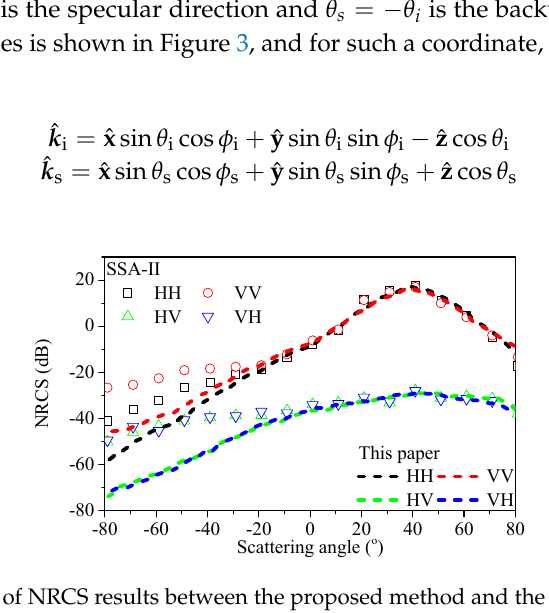
Figure 3. The global and local coordinates on a facet. 2.2. Diffuse Scattering Region In the off-nadir region, first order Bragg scattering is the main contribution to the co-polarized scattered field [18–20]. However, both the tilt modulation and the second order Bragg scattering contribute to the depolarization. Even though the second order Bragg scattering mechanism contributed to the cross-polarization scattering field, there was only about a 2~4 dB difference if it is neglected when